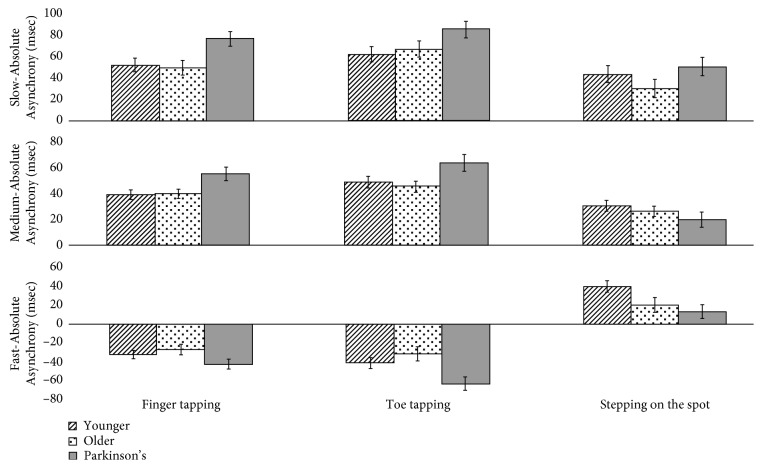
The effect of movement modality on Absolute Asynchrony in all tempi by group. Y-axis shows Absolute Asynchrony in ms. X-axis shows group by movement modality.